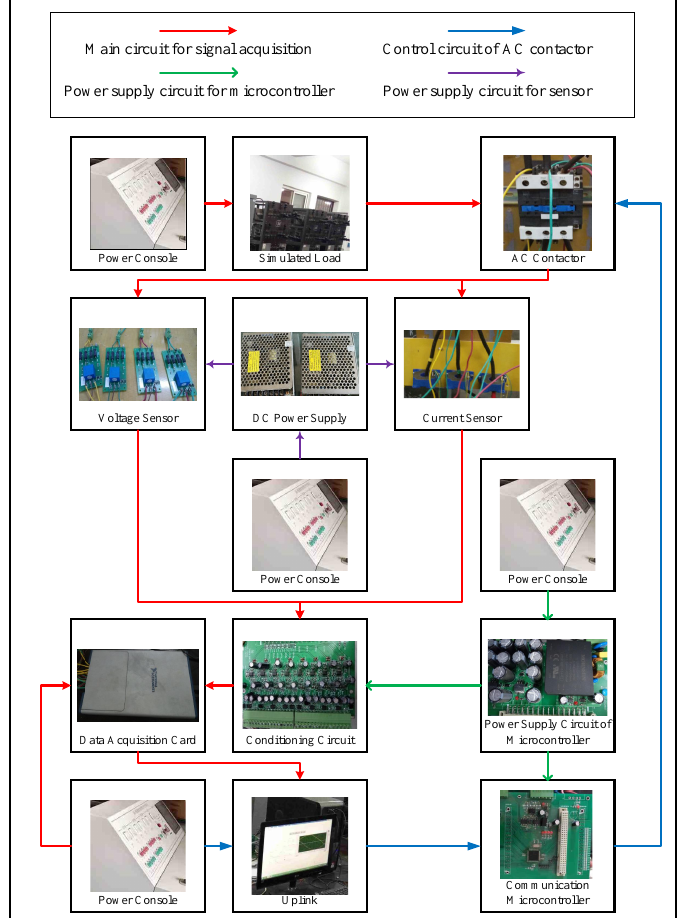
Figure 10. Schematic diagram of the test platform.